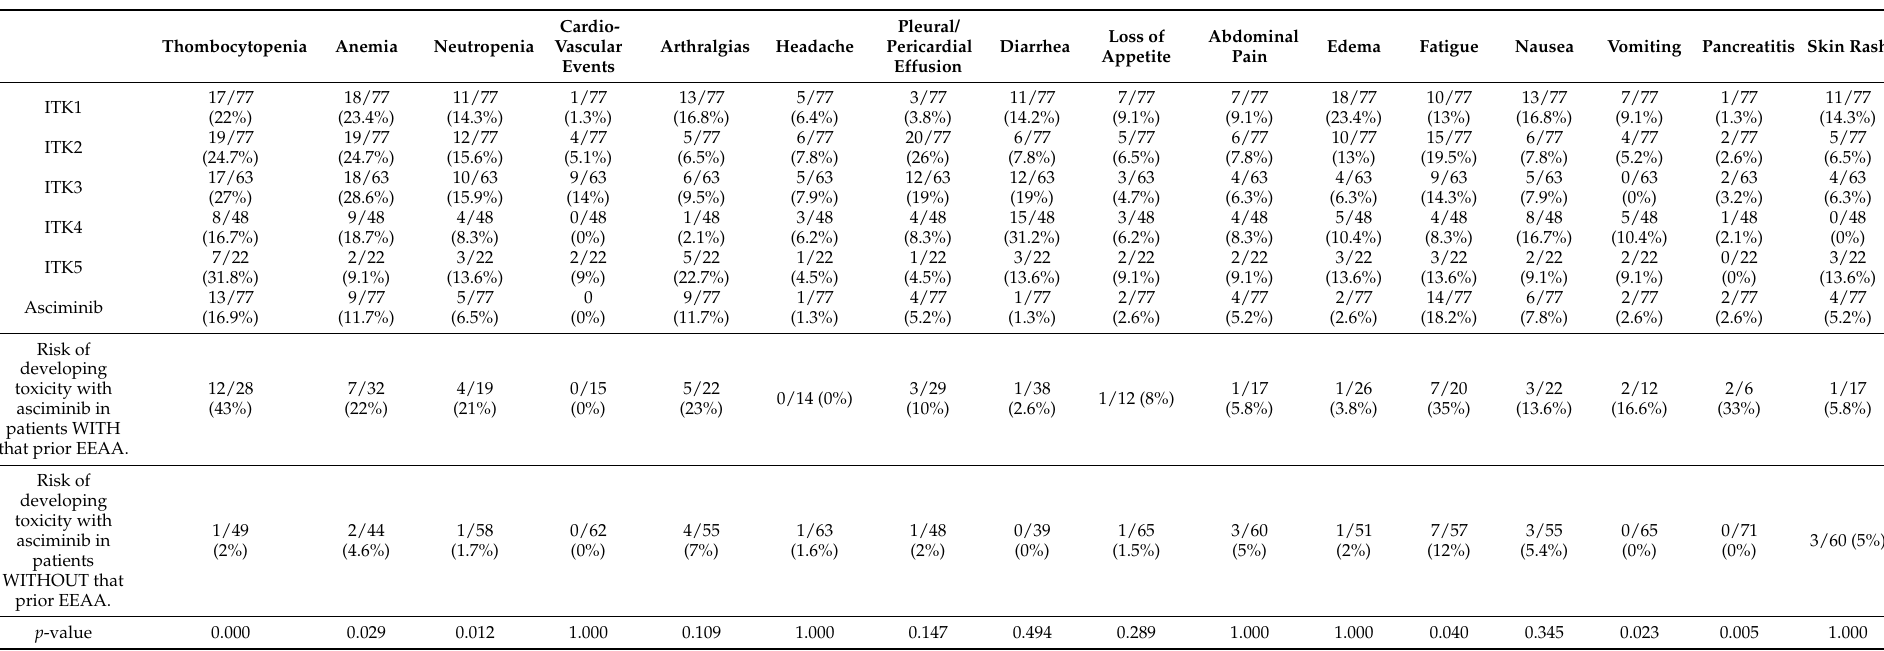
Table 2. Frequency of different toxicities with each of the lines of treatment and with asciminib. At the bottom: cross-toxicity analysis. Frequency in the group with a history of the adverse effect and frequency in the group without a history of the adverse effect. AE, adverse